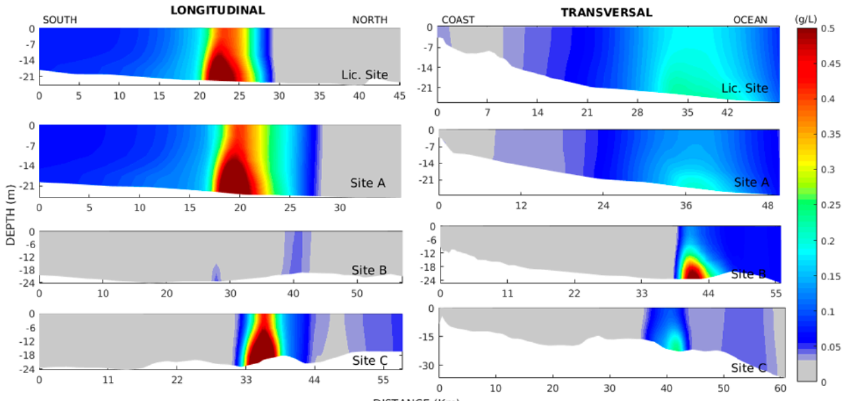
Figure 8. Longitudinal ( left column) and transversal ( right column) profiles representing the disper- sion plume throughout the vertical after 216 discharges (starting on 06 December 2013 at 00:00 h) on the licensed and alternative disposal Sites A, B, and C. Color scale indicates suspended sediment concentrations (g/L), where gray indicates concentrations lower than 0.025